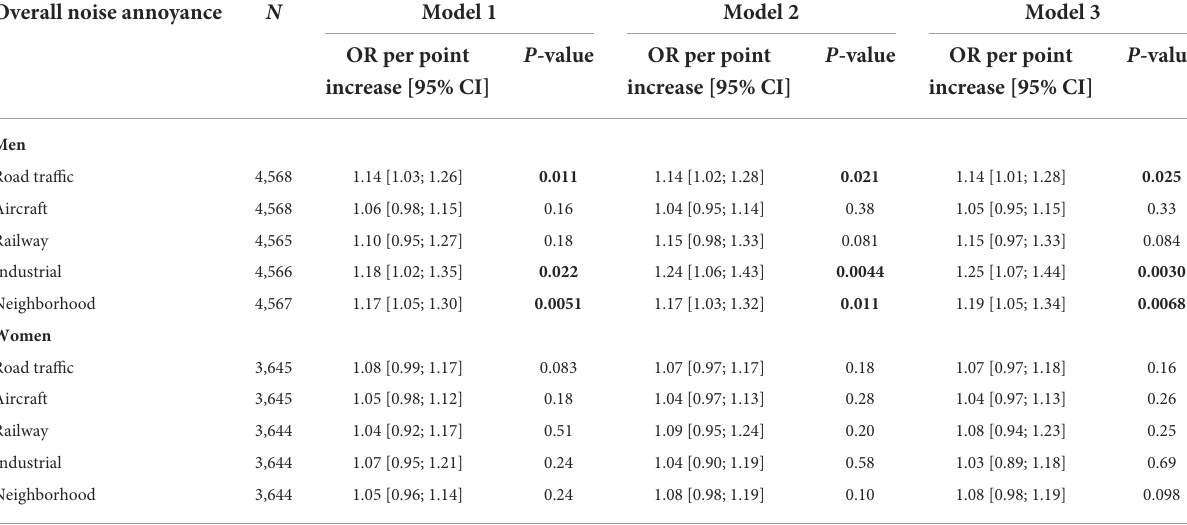
TABLE 3 Prospective association analysis between source-specific overall noise annoyance and incidence of atrial fibrillation in men and women (data from the Gutenberg Health Study 2007–2017). Overall noise